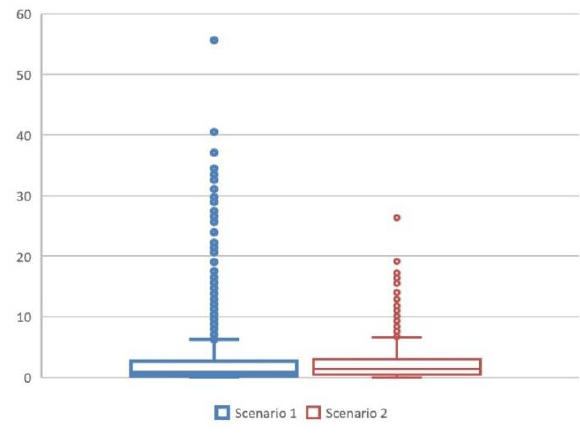
Figure 12. Boxplot for SSPD metric for Scenario 1 (blue) and 2 (red).